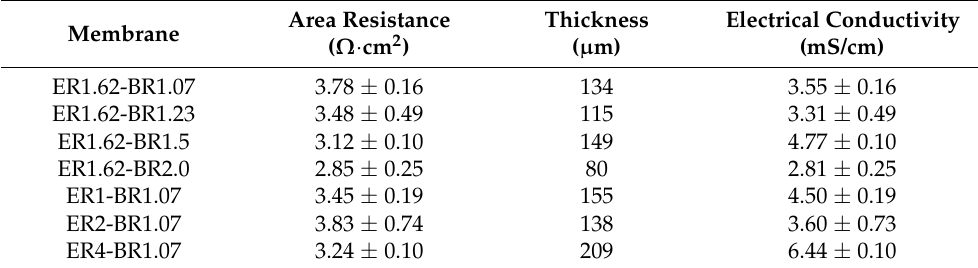
Table 5. Area resistance and electrical conductivity values of AEMs.